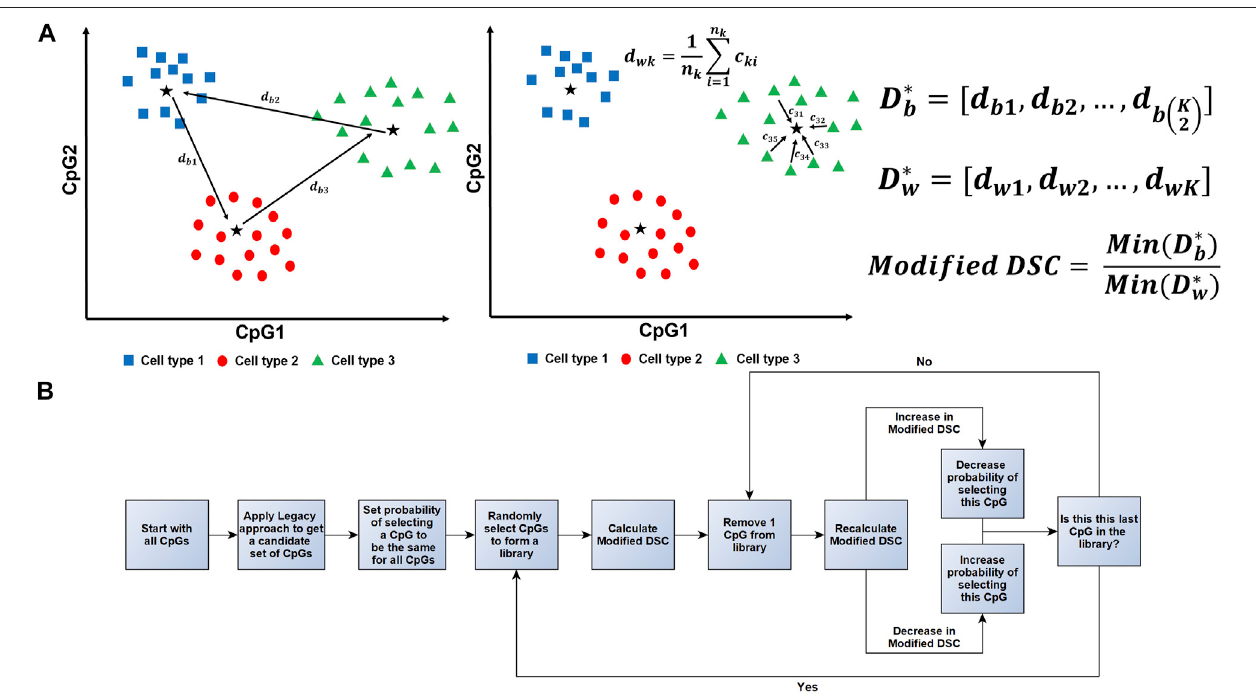
FIGURE 2 | Illustration of the Modi fi ed DSC Calculation and Work fl ow. (A) A conceptual illustration of how the Modi fi ed DSC is calculated assuming three different cell types and two CpGs. ( A, Left ) d b 1 , d b 2 and d b 3 representthe Euclideandistancesbetween pairs ofcell-type-speci fi c centroids (denoted asstars).These distances are elements of the vector, D p b , which represents the between-cell type dispersion index. ( A, Right ) c ik , k (cid:1) 1 , 2 , ... , K and i (cid:1) 1 , 2 , ... , n k , represent the Euclidean distancesbetween each sample ofagiven celltype and the centroid (denoted asstar)for thatcelltype where k isanindex forcell type, and i isanindex forsample. (cid:12) n k The average within-cell type distance is represented by d wk , where d wk (cid:1) 1 i (cid:1) 1 c ik , and n k represents the number of samples for cell type k . These distances are the n k elements of the vector, D p w , which represents the within-cell type dispersion index. The modi fi ed DSC is then calculated as the ratio of the minimum between-cell type dispersionandtheminimumwithin-celltypedispersion, Min ( D p b